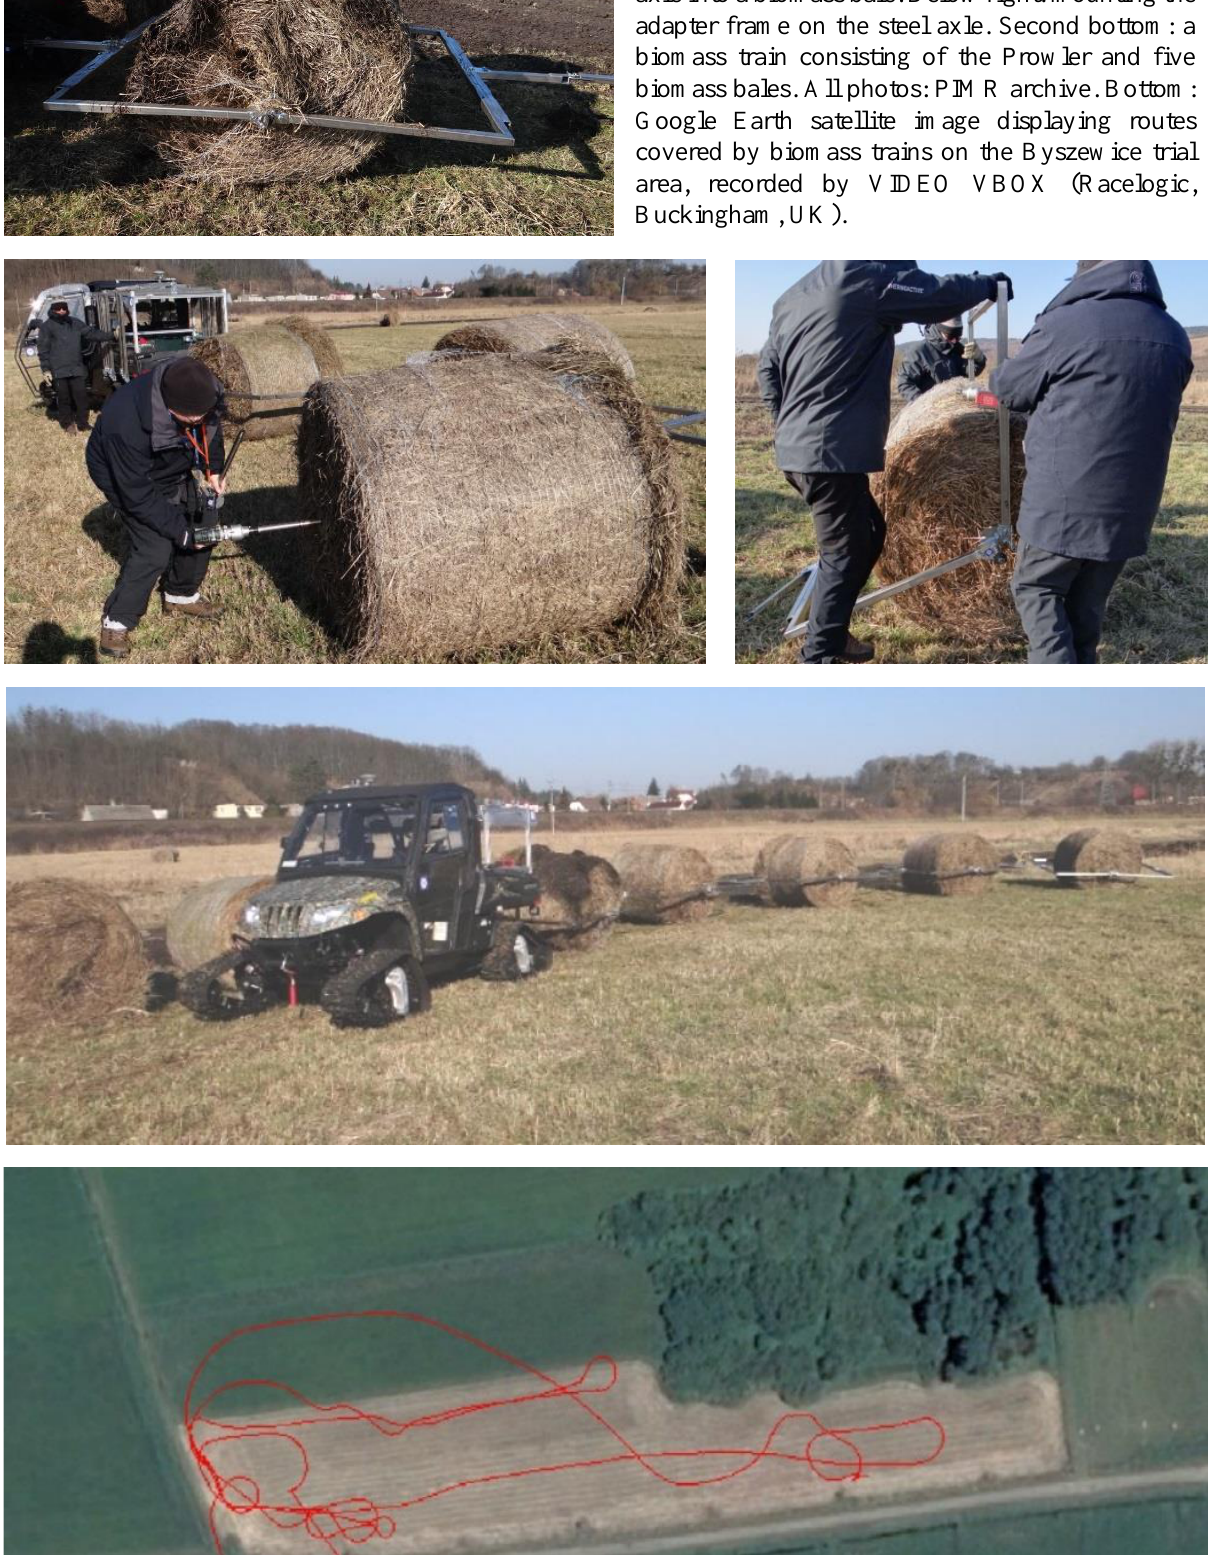
Figure 5. The trials of the biomass train in February 2015. Left: a biomass bale that had become deformed during six months’ storage in the open air; such bales could still be rolled for more than 1 km in a biomass train. Below left: drilling a steel axle into a biomass bale. Below right: mounting the adapter frame on the steel axle. Second bottom: a biomass train consisting of the Prowler and five biomass bales. All photos: PIMR archive. Bottom: Google Earth satellite image displaying routes covered by biomass trains on the Byszewice trial area, recorded by VIDEO VBOX (Racelogic, Buckingham,